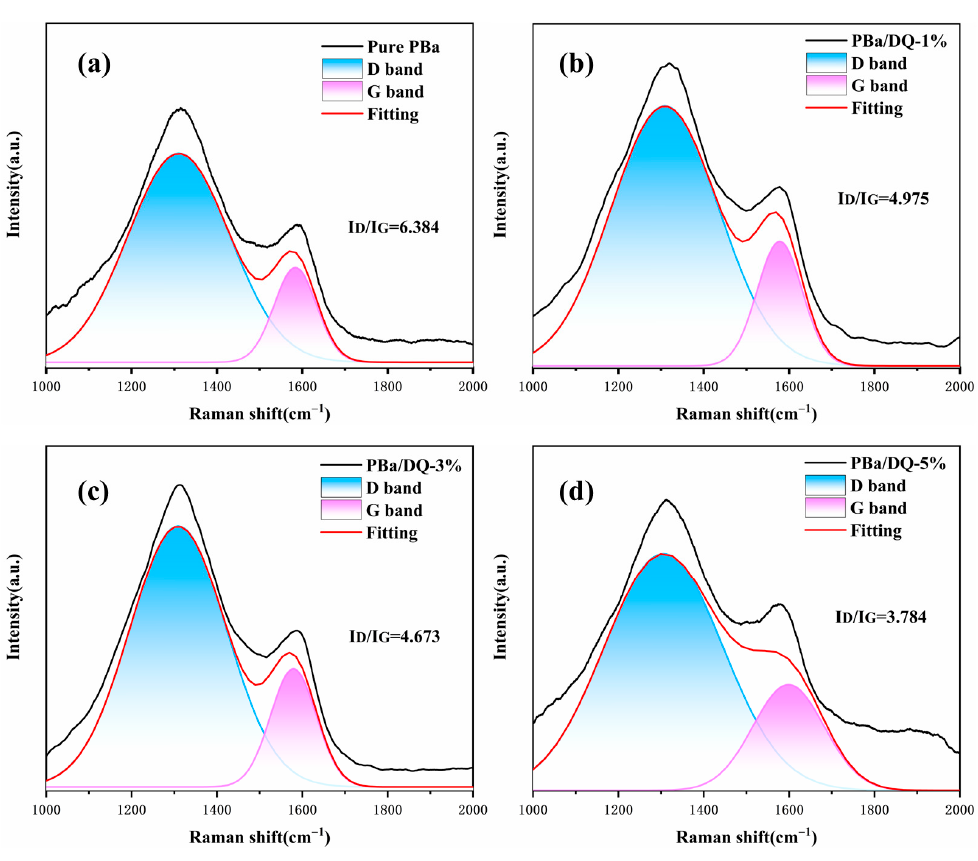
Figure 10. Raman spectra of charred residue of ( a ) PBa; ( b ) PBa/DQ-1%; ( c ) PBa/DQ-3%; ( d ) PBa/DQ-5%.